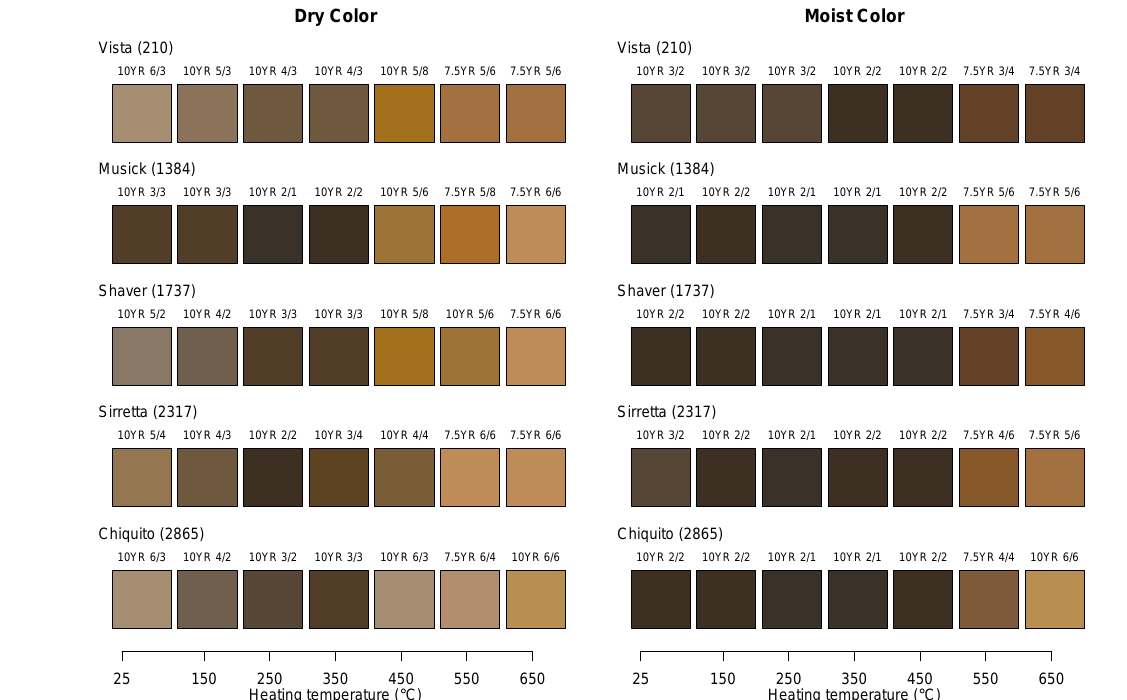
Figure 3. Soil color change across heating temperatures. Colors produced from CIExyY colorspace equivalents to Munsell colors (Munsell Color Science Laboratory, 2015). CIExyY colors were converted to RGB system (Rossel et al., 2006; UC Davis Soil Resource Laboratory, 2015) and visually compared with Munsell Soil Color book for